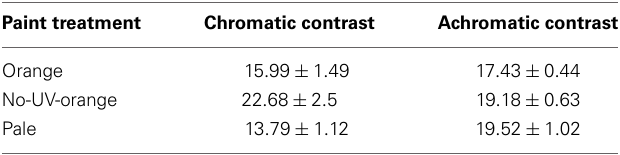
Table 1 | Chromatic and achromatic (luminance) contrasts against the natural salt crust background for each paint treatment.